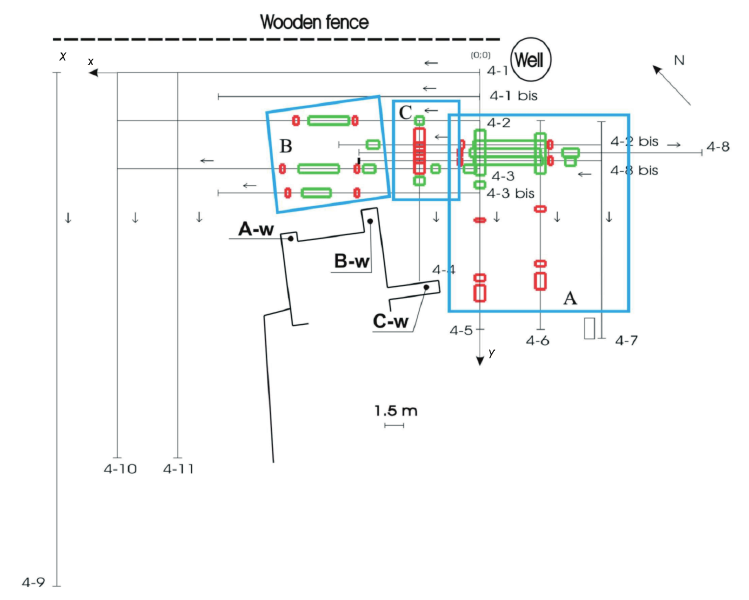
Fig. 3. Structures pointed out by the GPR